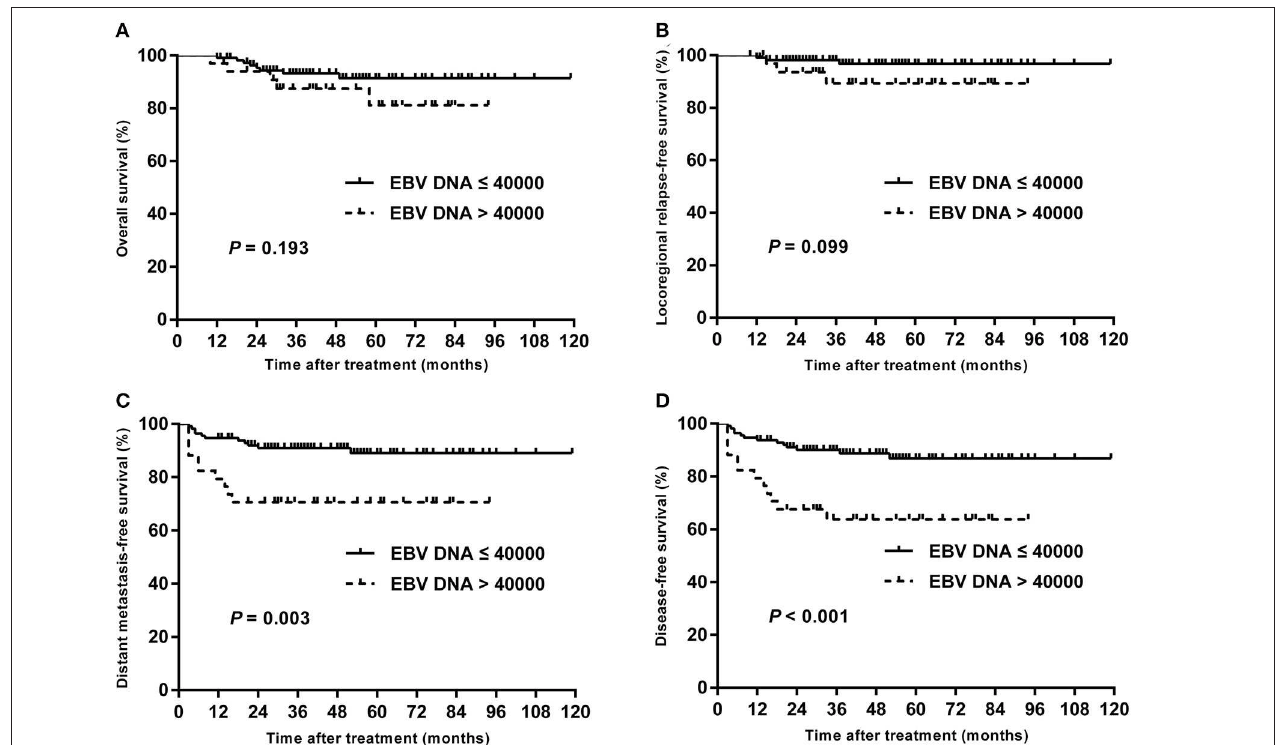
FIGURE 2 | Kaplan–Meier estimate of the OS (A) , LRRFS (B) , DMFS (C) , and DFS (D) of children and adolescent NPC patients according to pretreatment EBV DNA levels.